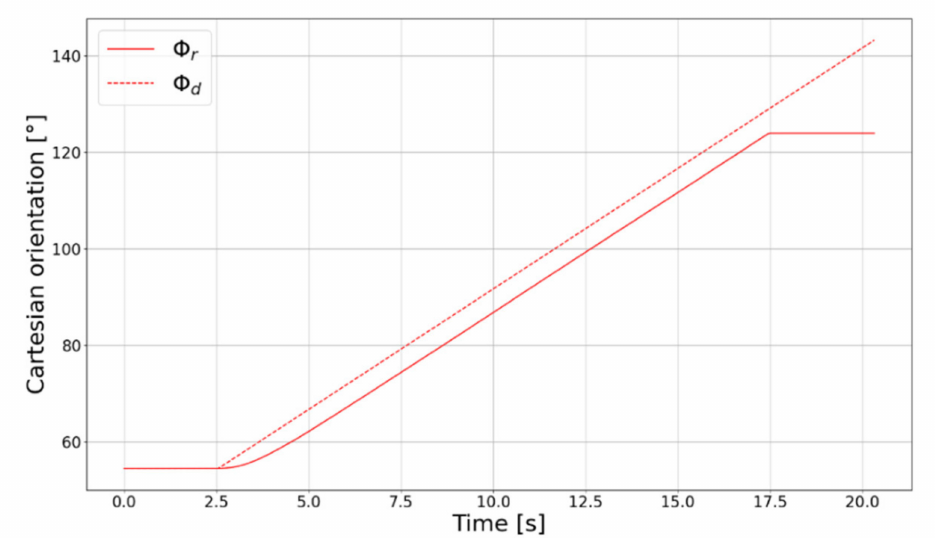
Figure 17. Comparison between the desired probe self-rotation φ d and the executed self-rotation φ r in the absence of a JLA